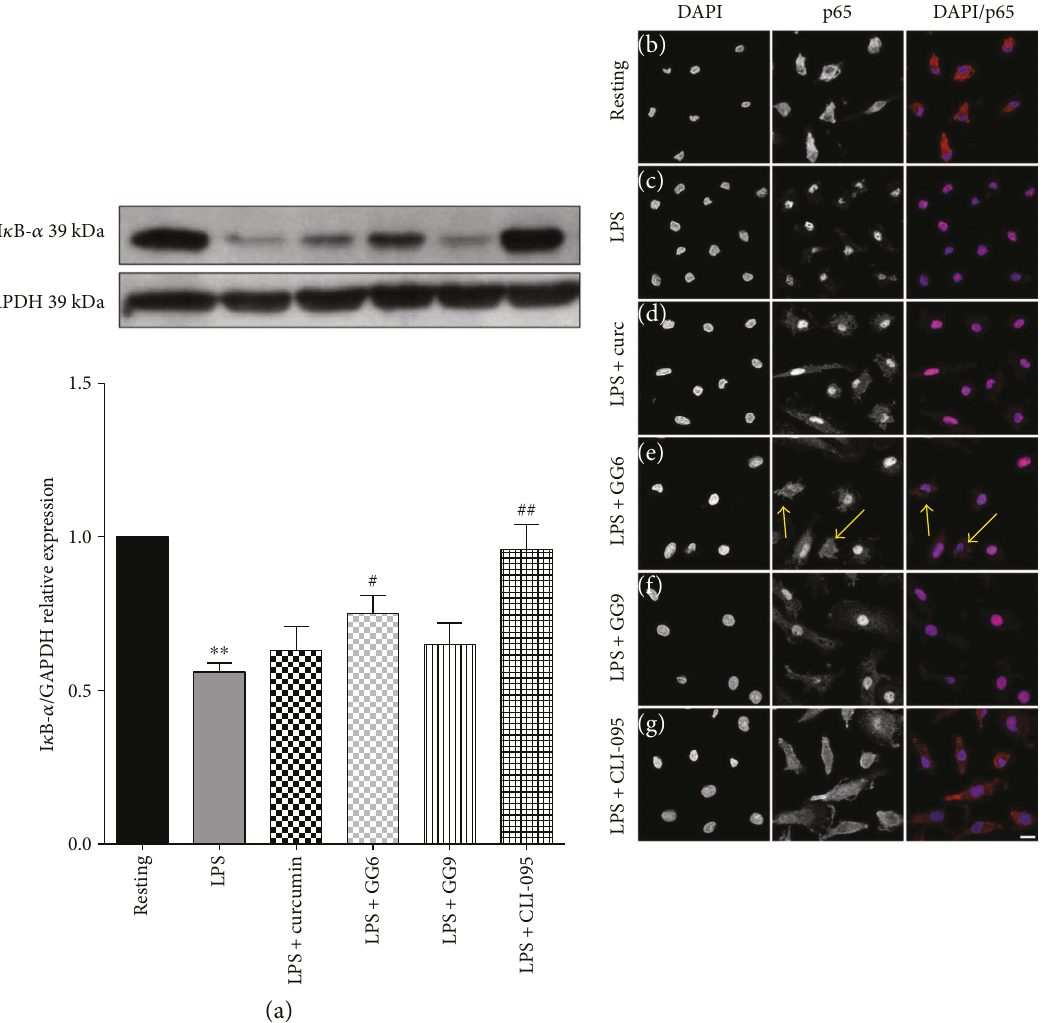
Figure 4: (a) I κ B- α immunodetection in CSF-1-driven macrophages. Total protein extracts from resting, LPS-stimulated M1, and test agent- pretreated M1 macrophages were assayed after 30min LPS incubation. GAPDH served as loading control. Bars represent the mean ( ± SEM) of 4 independent experiments. Results from representative immunoblots are shown. ∗∗ p < 0 0005 versus resting; # p < 0 05 ; and ## p < 0 005 versus LPS. (b – g) Cells were pretreated with curcumin, GG6, GG9, and CLI-095 before stimulation with LPS, and then processed for NF- κ B p65 immunostaining. Representative confocal images showing subcellular localization of p65 in unstimulated and LPS-stimulated macrophages are shown in (b) and (c), respectively. Treatment with curcumin, GG6, GG9, and CLI-095 are shown in (d – g), respectively. Arrows indicate representative cells with attenuated p65 staining. Scale bar: 10 μ m; magni fi cation: